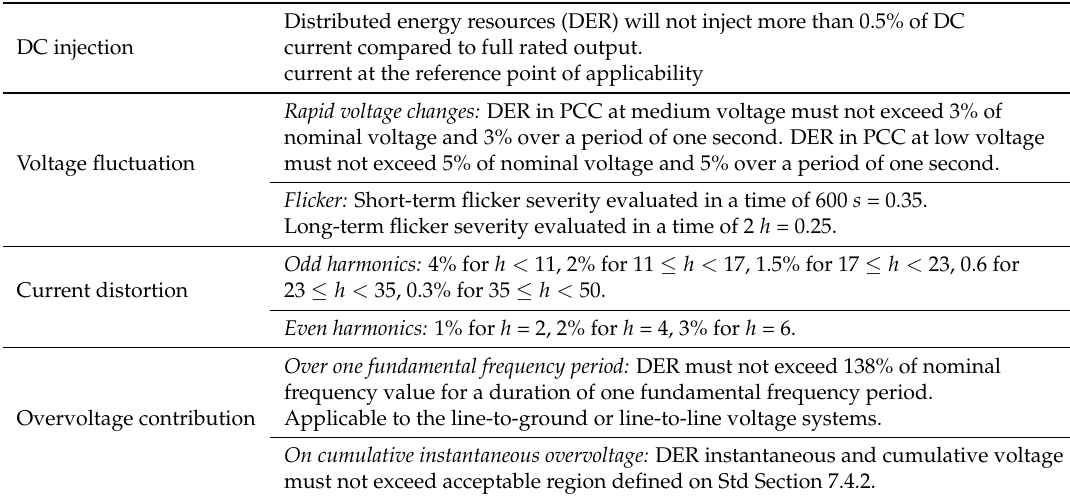
Table 2. Power quality requirements on IEEE Std 1547-2018.